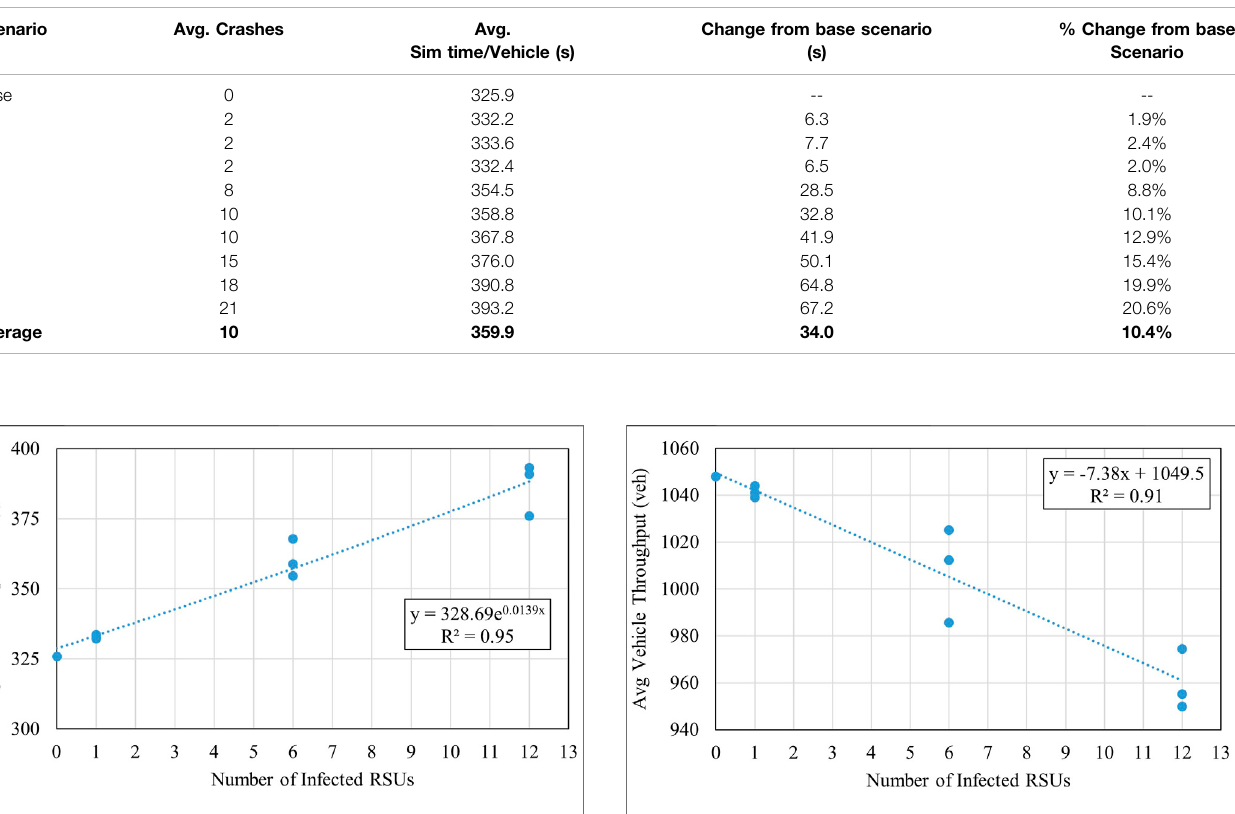
TABLE 2 | DoS scenarios - relative travel time delay.